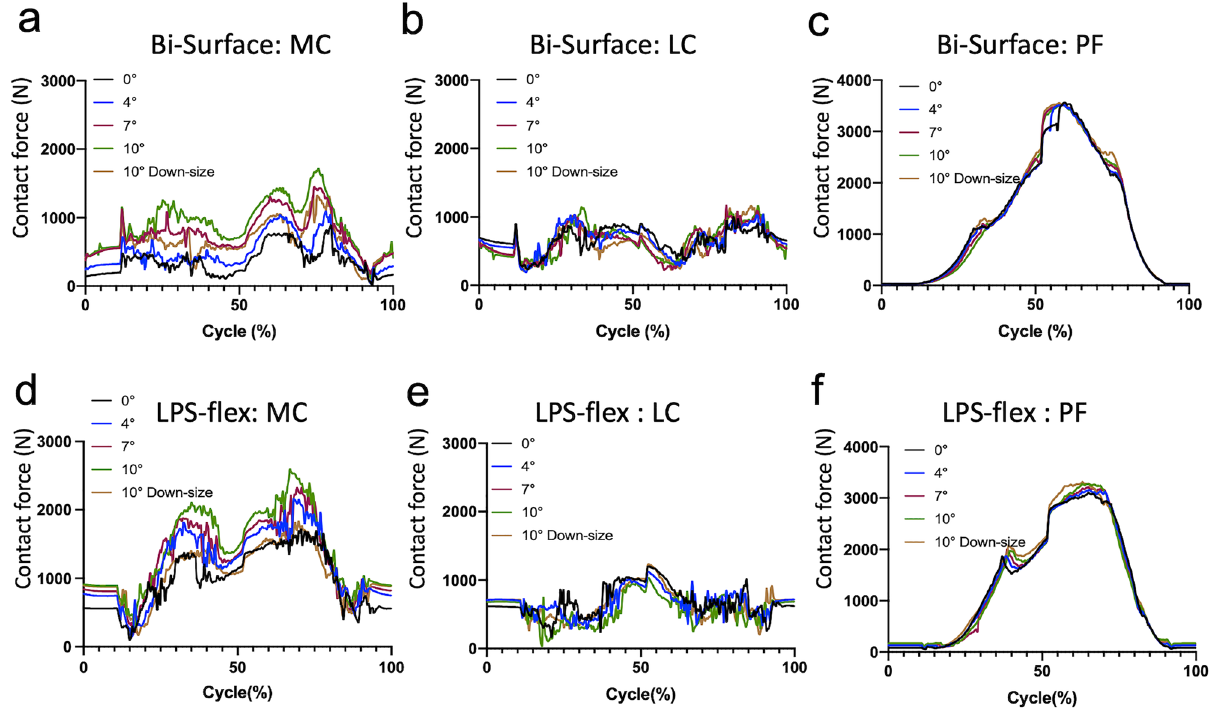
Figure 3. Contact force in the Bi-Surface Knee ( a – c ) and LPS-flex ( d – f ). ( a , d ) medial compartment, ( b , e ) lateral compartment, ( c , f ) patellofemoral joint. MC medial compartment, LC lateral compartment, PF patellofemoral joint.